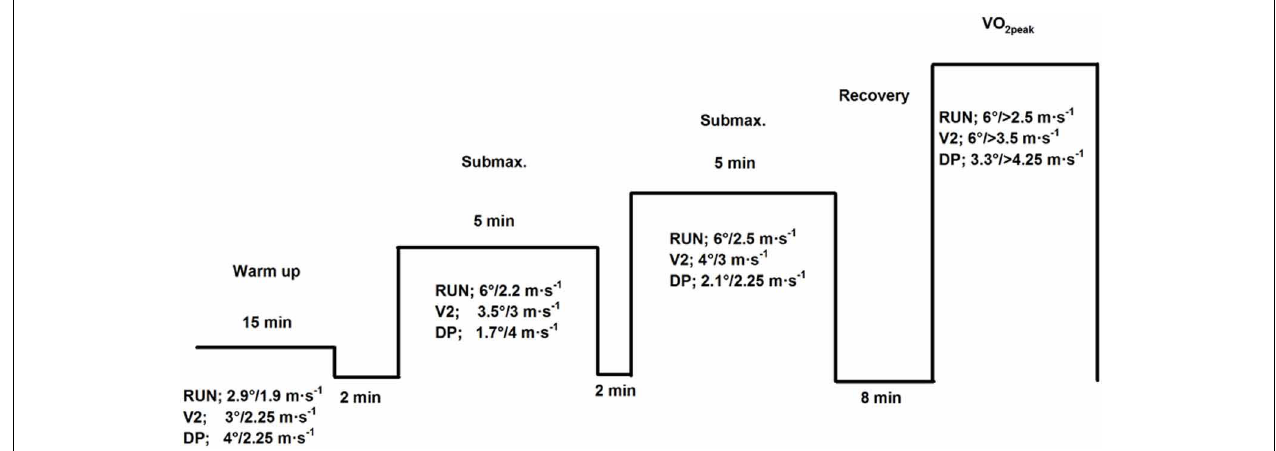
FIGURE 1 | Schematic protocol of the study. Steady-state VO 2 (exercise economy) was measured at two submaximal workloads of 5min each, followed by a maximaltestperformedasa1000-mtestinthetwoskiingtechniquesandanincrementaltestinrunning.ExercisemodeswereV2-skating,doublepolingandrunning.